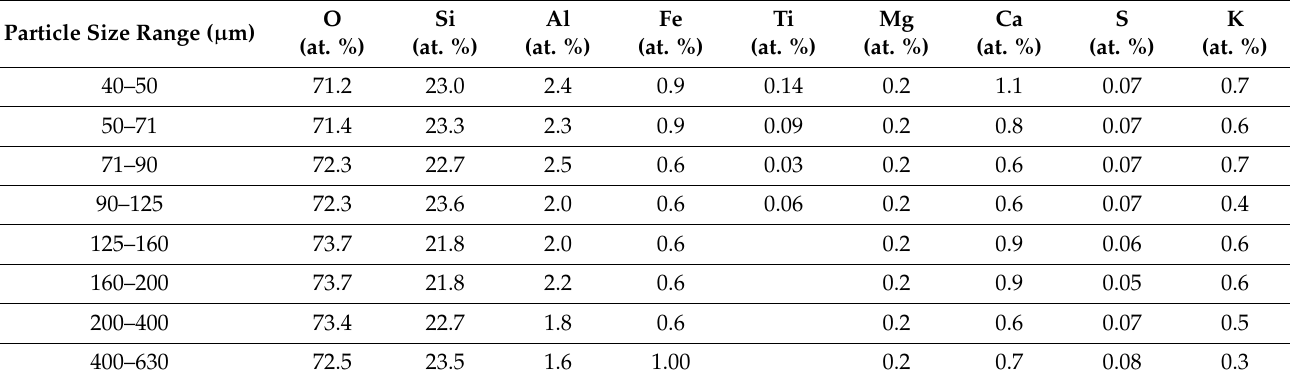
Table 1. Average quantitative mineralogical analysis of quartz sand particle